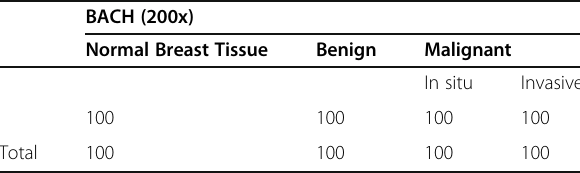
Table 2 Summarized composition of the number of images on the BACH